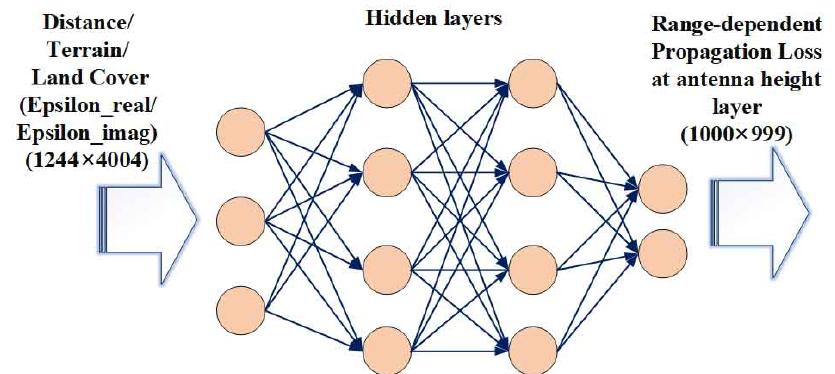
Figure 28. The schematic diagram of the deep learning forward-prediction